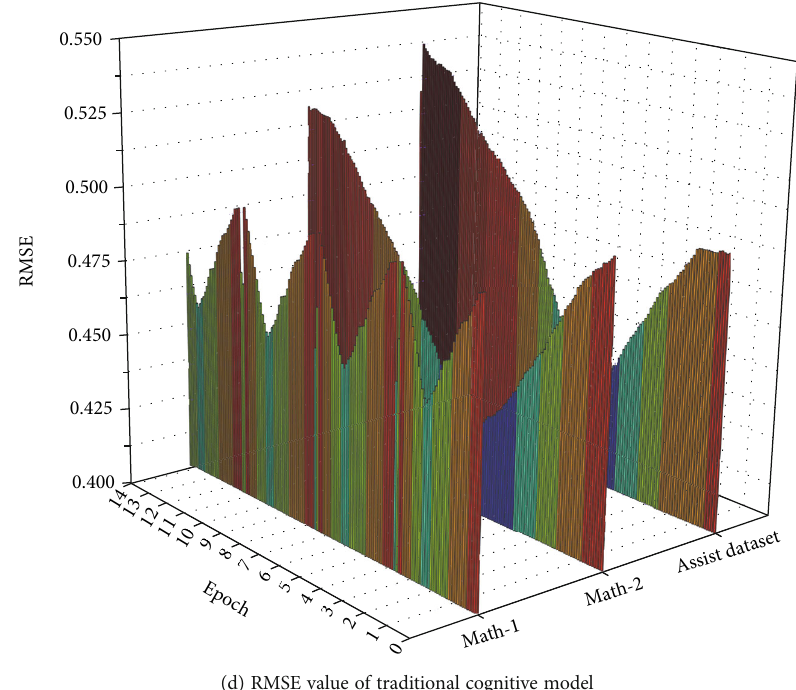
Figure 5: Loss value and RMSE value of di ff erent cognitive models on three data